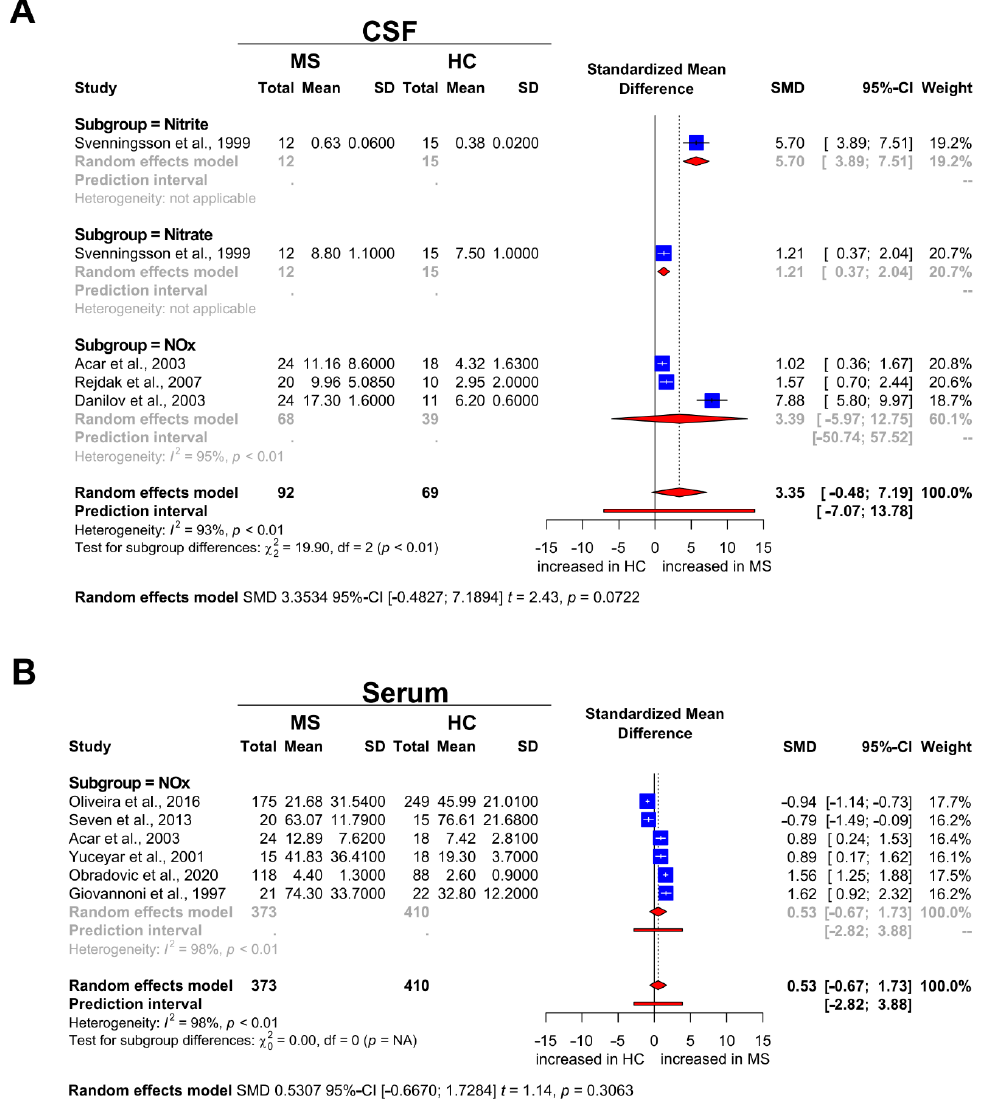
Figure 3. Forest plot displaying the meta-analysis for markers of nitrosative stress in ( A ) the CSF and ( B ) the serum compartment for MS vs. HC, respectively. The dashed vertical line indicates the overall effect, while the solid line indicates the null effect (SMD = 0). Abbreviations: CSF = cerebrospinal fluid, HC = healthy controls, NOx = sum of nitrite and nitrate levels, MS = multiple sclerosis, SD = standard deviation, SMD = standardized mean difference.